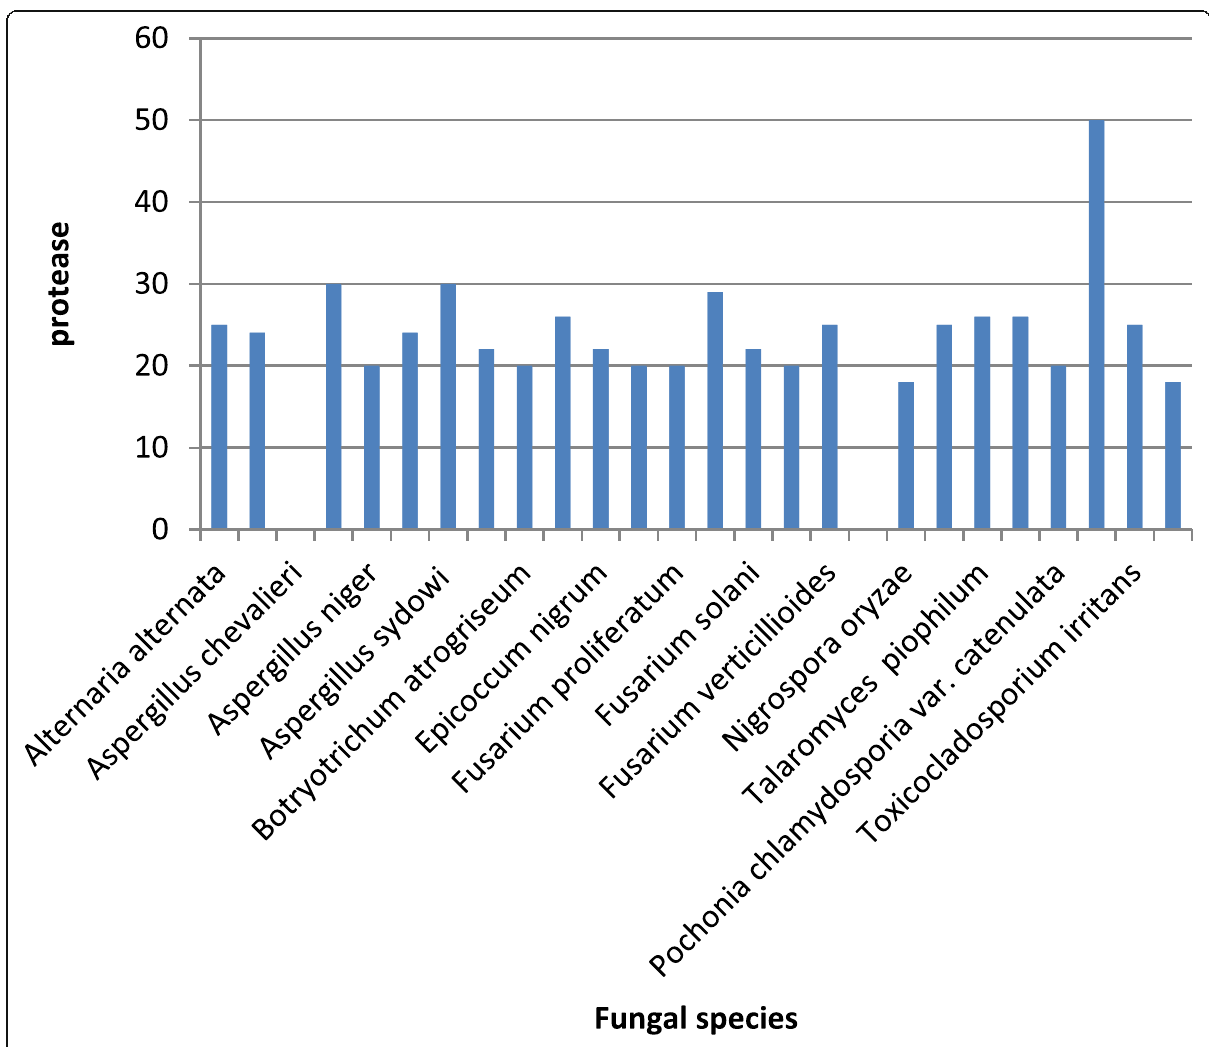
Fig. 3 Proteases activity of fungal species isolated from